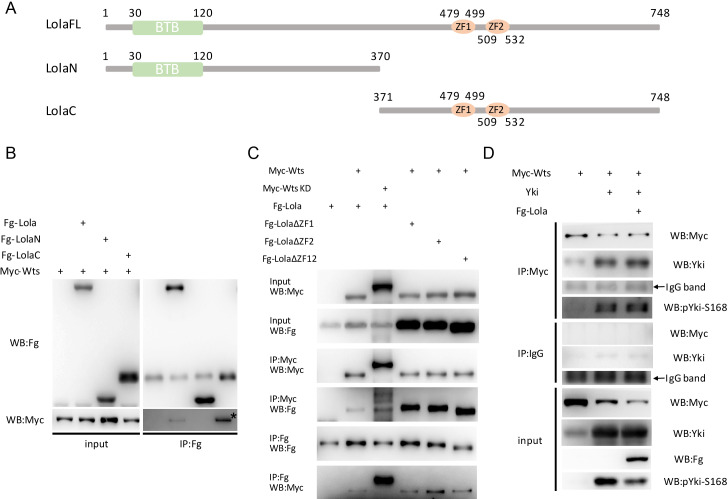
Wts interacts with C-terminal Lola independently of Wts kinase activity and Lola zinc finger domains.(A) Schematic presentation illustrating Lola (LolaFL), truncated Lola N-terminus containing the BTB domain (1–370, LolaN), and truncated Lola C-terminus containing two zinc finger domains (371–748, LolaC). (B) Collected cell extracts from S2 cells transfected with plasmids expressing Fg-Lola, Fg-LolaN, or Fg-LolaC and Myc-Wts were analyzed by Co-IP with the indicated antibodies. Note that Wts co-immunoprecipitated with C-terminal Lola (asterisk). (C) Collected cell extracts from S2 cells transfected with plasmids expressing Fg-Lola, Fg-LolaΔZF1, Fg-LolaΔZF2, or Fg-LolaΔZF12 and Myc-Wts or Myc-WtsKD were analyzed by Co-IP with the indicated antibodies. Note that Wts-Lola interaction is independent of Wts kinase activity and Lola zinc finger domains. (D) Collected cell extracts from S2 cells transfected with plasmids expressing Fg-Lola, Yki, and Myc-Wts were analyzed by Co-IP with the indicated antibodies. Note that the total amount of co-immunoprecipitated Yki and its phosphorylation levels at S168 (pYki-S168 panel) are similar in the presence or absence of Myc-Wts.